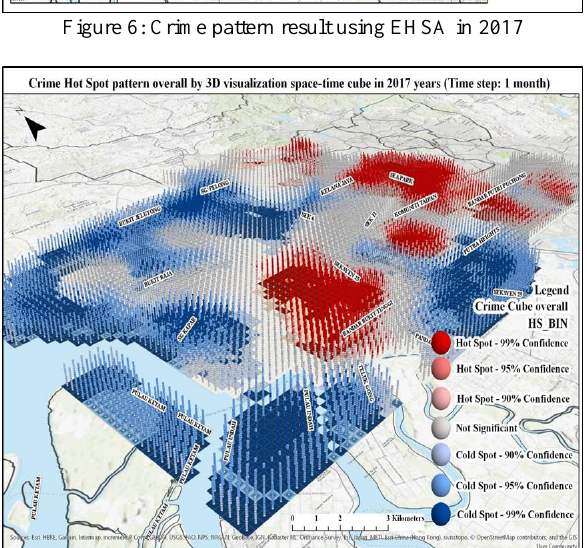
Figure 6: Crime pattern result using EHSA in 2017